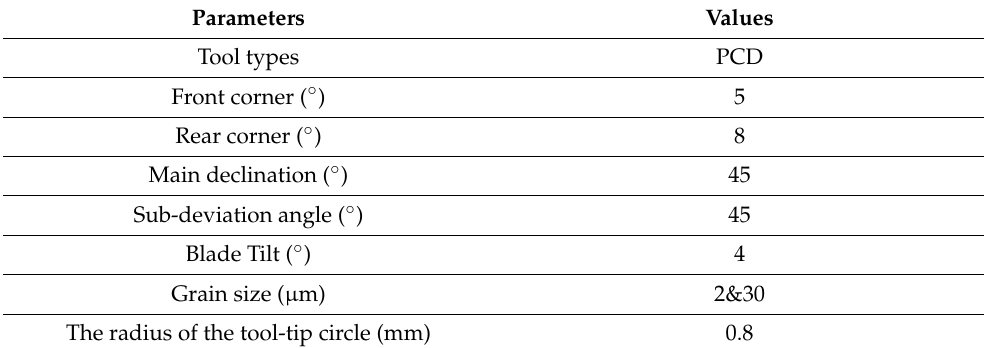
Table 5. PCD tool working angle and grain size.